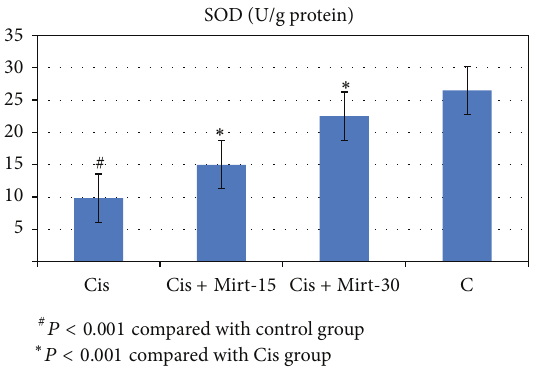
Figure 7: SOD activity of study